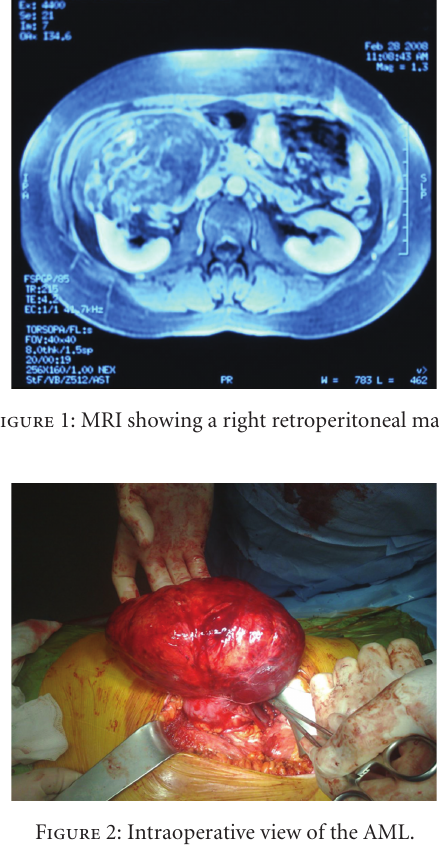
Figure 4: MRI of the right kidney, 6 months after the